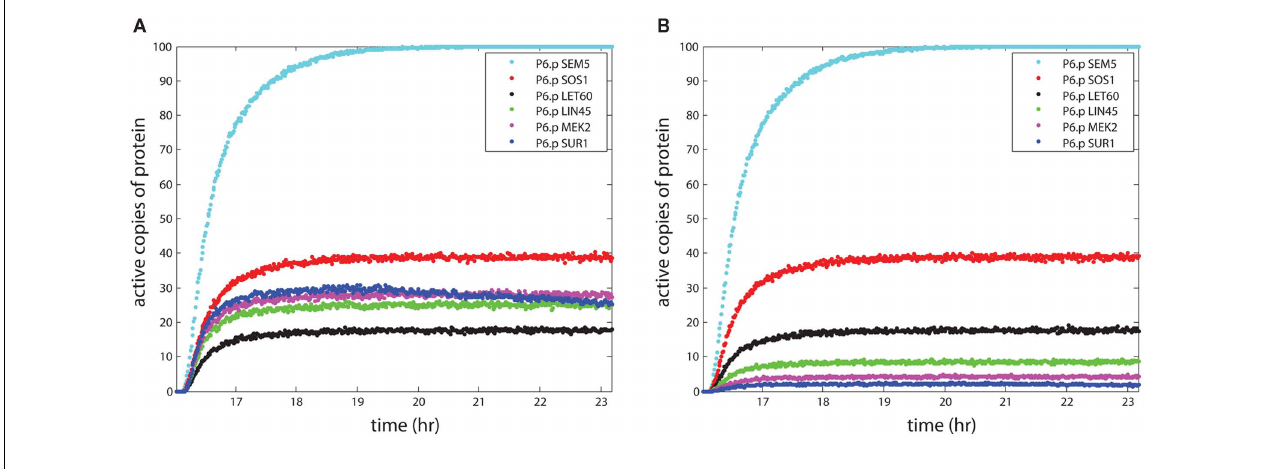
In (A) , the effect of the scaffold is seen as the signal stabilizes for proteins bound to the scaffold and enhances signaling in the wild-type worm. In (B) , the KSR scaffold is “knocked out,” leading to a continued loss of signal during